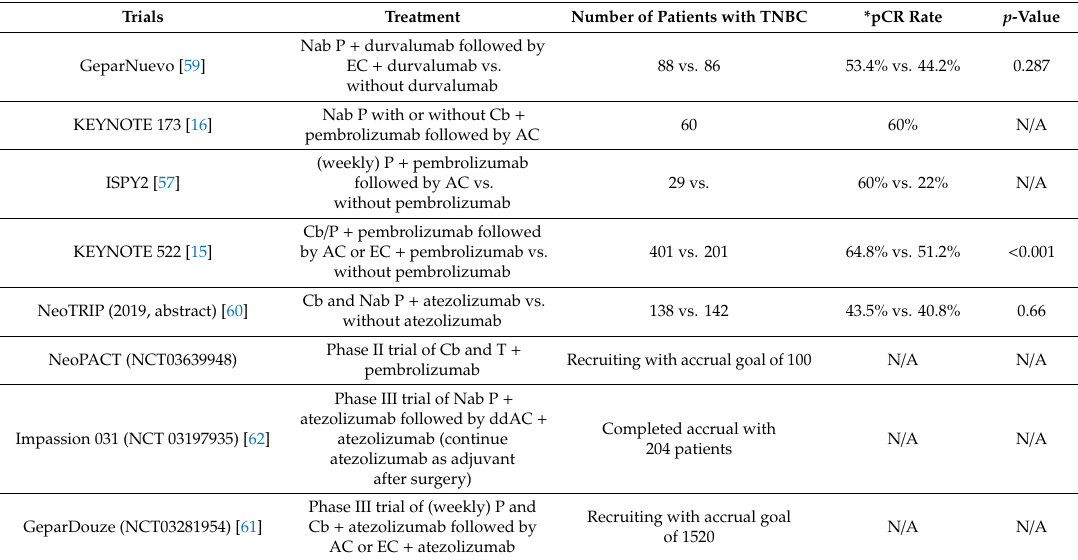
Table 3. Immune checkpoint inhibitor trials in early stage